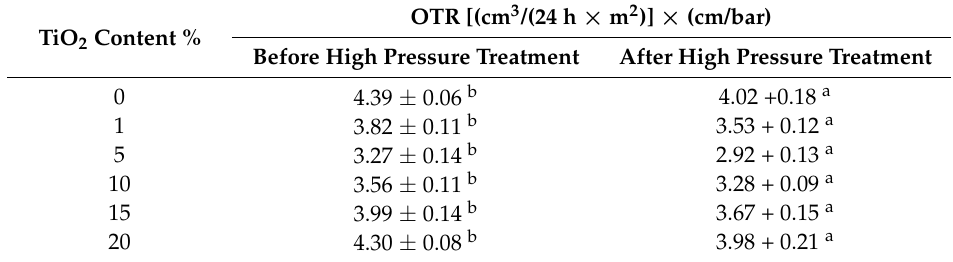
Table 4. Oxygen Transmission Rate of composite films with different ratios of nanoparticles before and after high pressure